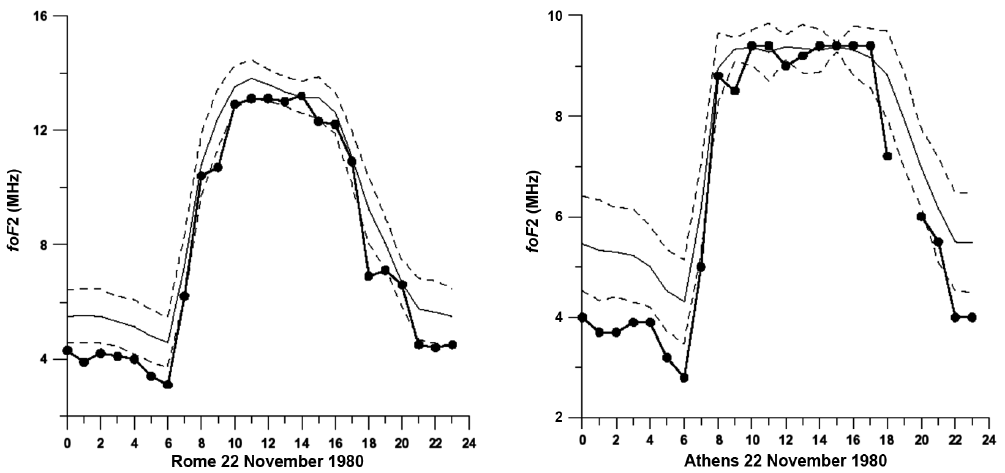
Fig. 12. Daily variations of the critical frequency (bold line with points) on 22nd November 1980 in Rome (left panel) and Athens (right panel). Continuous line – monthly mean, dashed lines ± σ